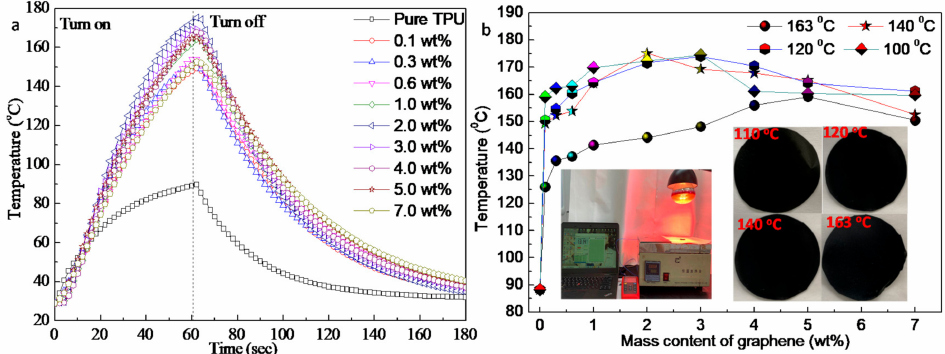
Figure 8. ( a ) Relationship of the temperature of the G-TPU composite films prepared from melting point TPU of 140 ◦ C and with different mass contents of graphene under the operation of IR lamp, and ( b ) the maximum temperature of the G-TPU composite films prepared from TPU with different melting points and the mass content of graphene. The insets are photos of the tested sample and samples at maximum